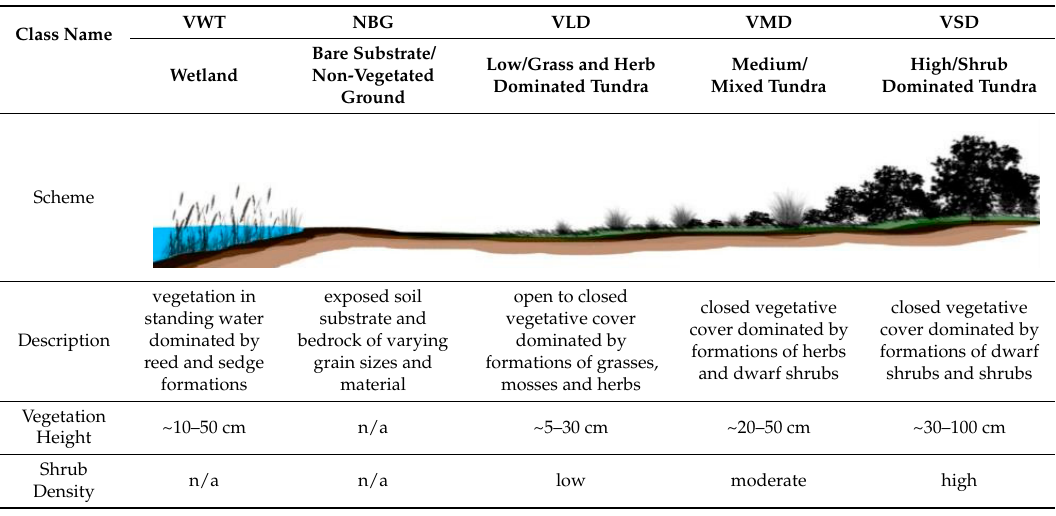
Table 2. Parameters, description, and scheme of the generalized land cover classes.